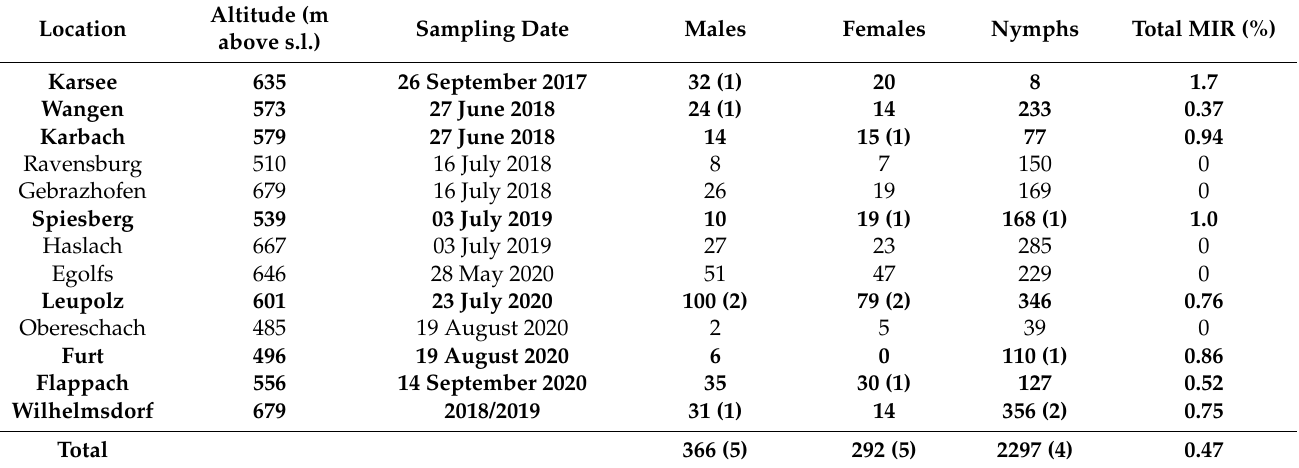
Table 2. Number of sampled ticks, tabulated by developmental stage and location. Positive locations are in bold font. Numbers in brackets indicate the number of TBEV-positive tick pools.